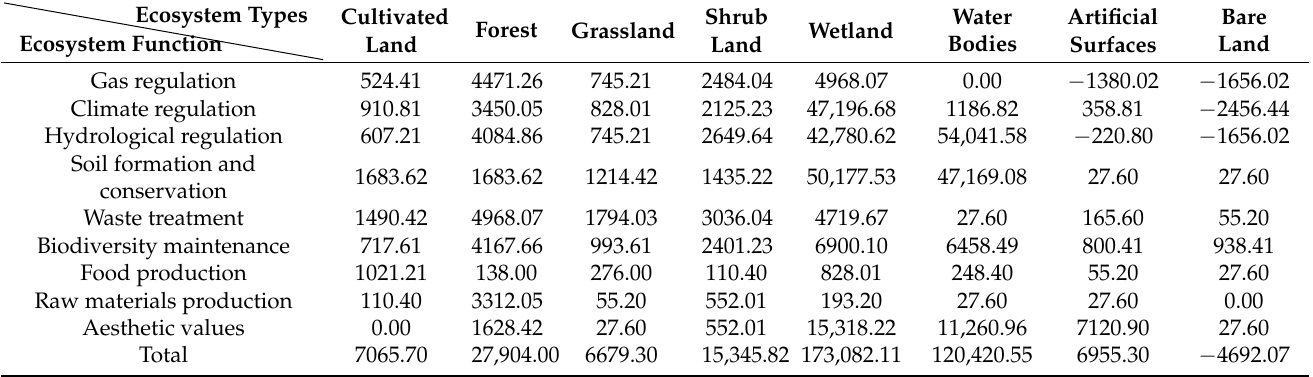
Table 4. The ESV of per unit area of different ecological types in the main stream of the Tarim River (unit: Yuan/hm 2